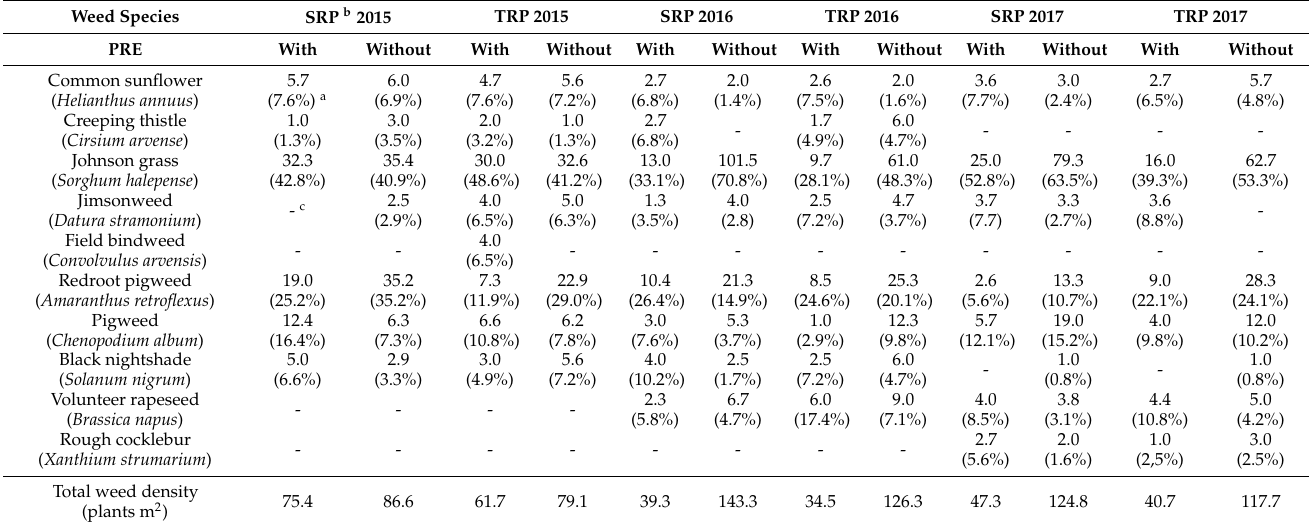
Table 3. The population density (average plants m − 2 ) of weed species in the experimental area in season-long weed treatment at VT stage (tasseling) of